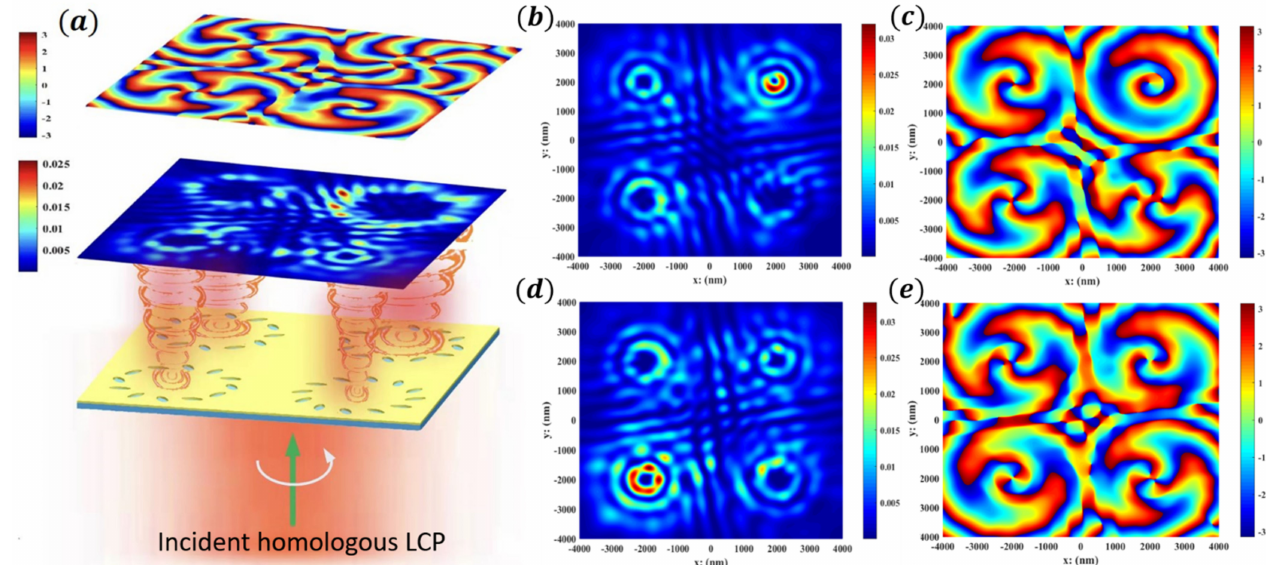
Figure 5. ( a ) Schematic diagram of homologous four-channel multi-order (8,6,4,2) OV array. ( b , c ) Scattering energy diagram and propagation section phase distribution diagram of homolo- gous four-channel multi-order (1,2,3,4) OVs. ( d , e ) Scattering energy diagram and propagation section phase distribution diagram of homologous four-channel multi-order (2,3,2,3)